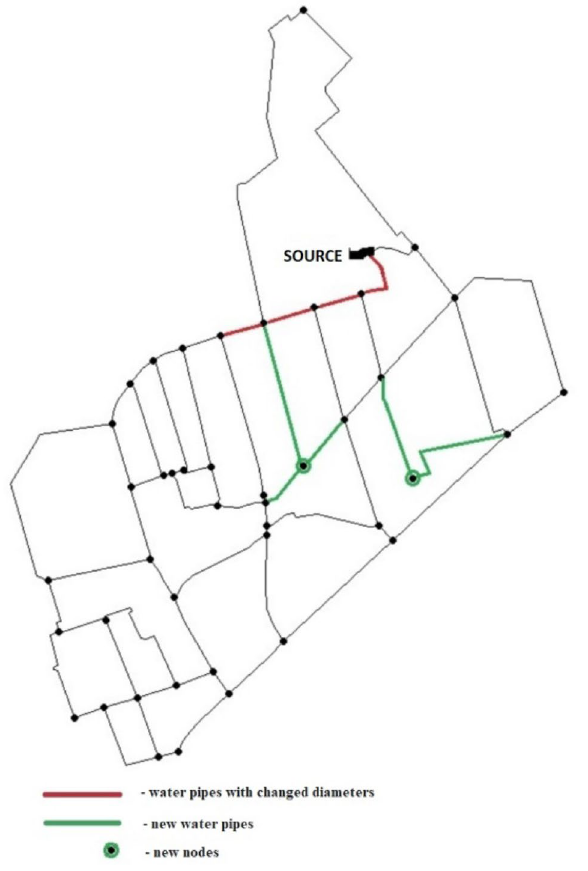
Fig. 5 Model diagram for the SYM_M variant with marked addi- tional elements